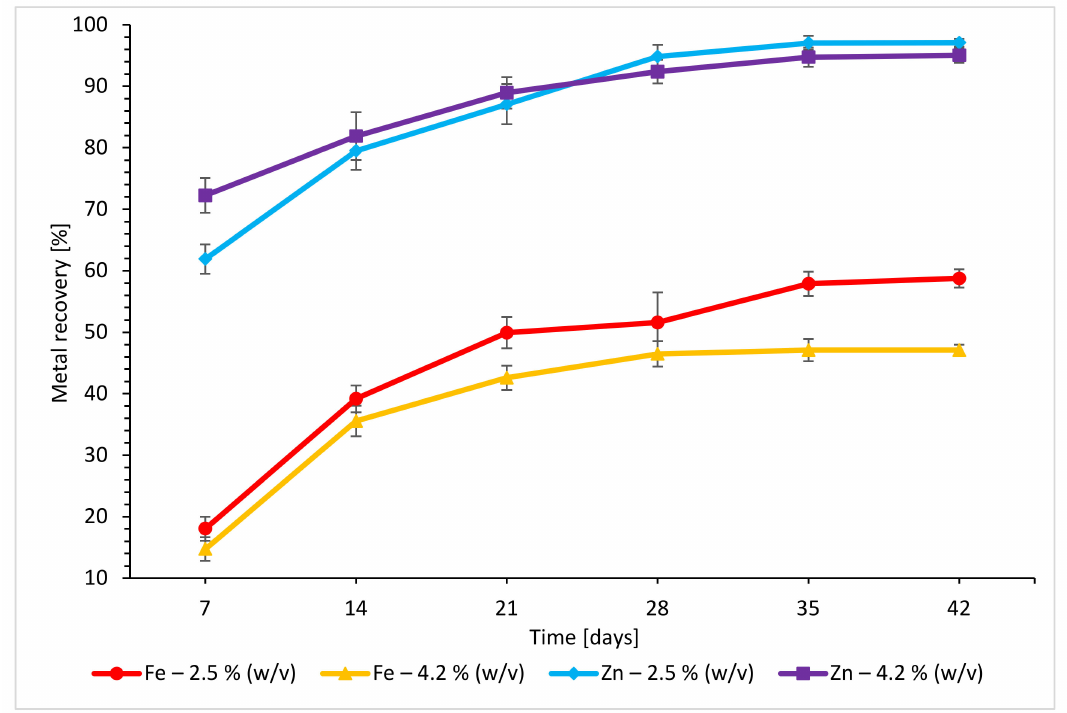
Figure 15. Influence of pulp density on Fe and Zn recovery (pH 2, stirring speed 100 rpm, and particle size < 40–200 µ